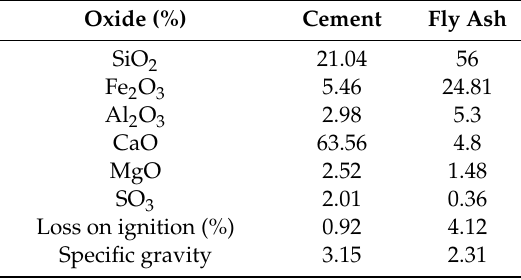
Table 1. Mixture proportions of fresh concrete.